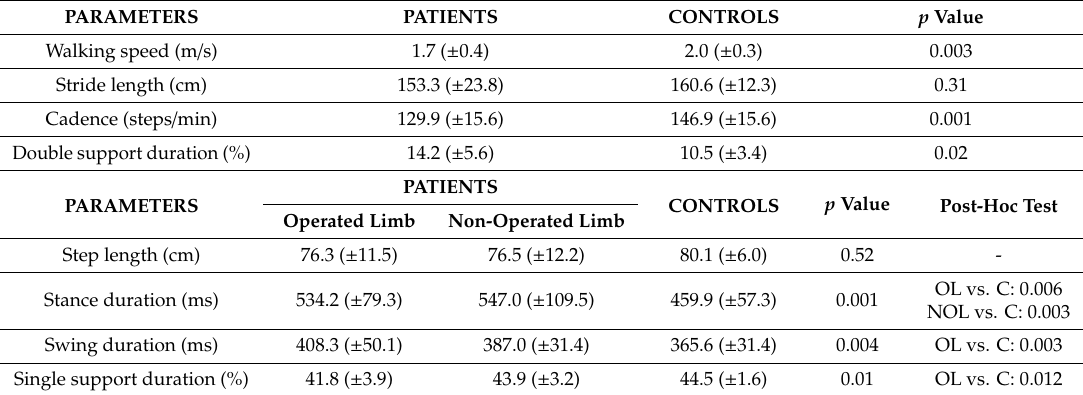
Table 2. Spatiotemporal parameters of gait at fast speed. Mean ( ± standard deviation) values are reported. OL: operated limb. NOL: non-operated limb. C: